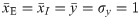
Sample-based PCA and learning performance.A: First three components of inputs ξμ with Gaussian singular value spectrum s for two different values of σx (color coded top panels). Parameters: N = 100, P = 300. B: Average error ϵerr for three different singular value spectra of the input sample covariance matrix: orthogonal model and Gaussian model with increasing σx (see main text for definition of σx). Outputs are i.i.d Gaussian. Parameters: N = 1000, fE = 0.8, γ = 0.1, x¯E=x¯I=y¯=σy=1, σI = 2σE = 0.6. B: Average error ϵerr for input with orthogonal-type covariance and output y with rbf-type covariance with decreasing σy (see main text for the definition of σy). All remaining parameters as in A. Full lines show analytical results. Points are averages across 50 samples.